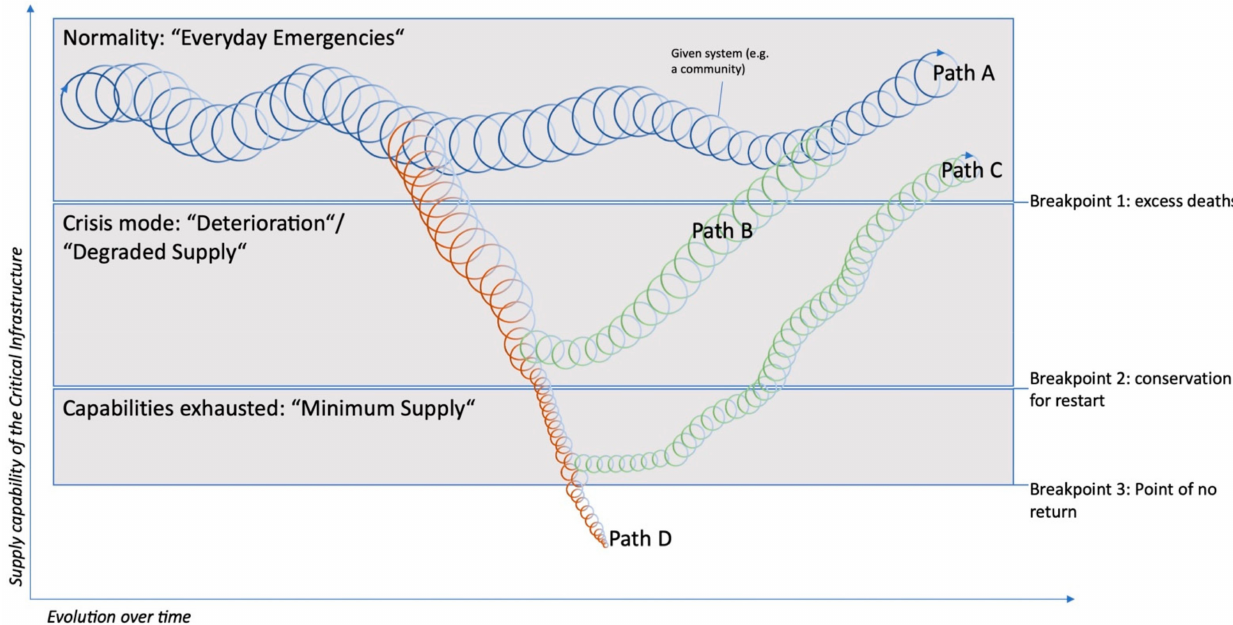
Figure 7. Corridors of emergency management and its capability to take care of a community (or other given system), deterioration, downward spiralling and recovery